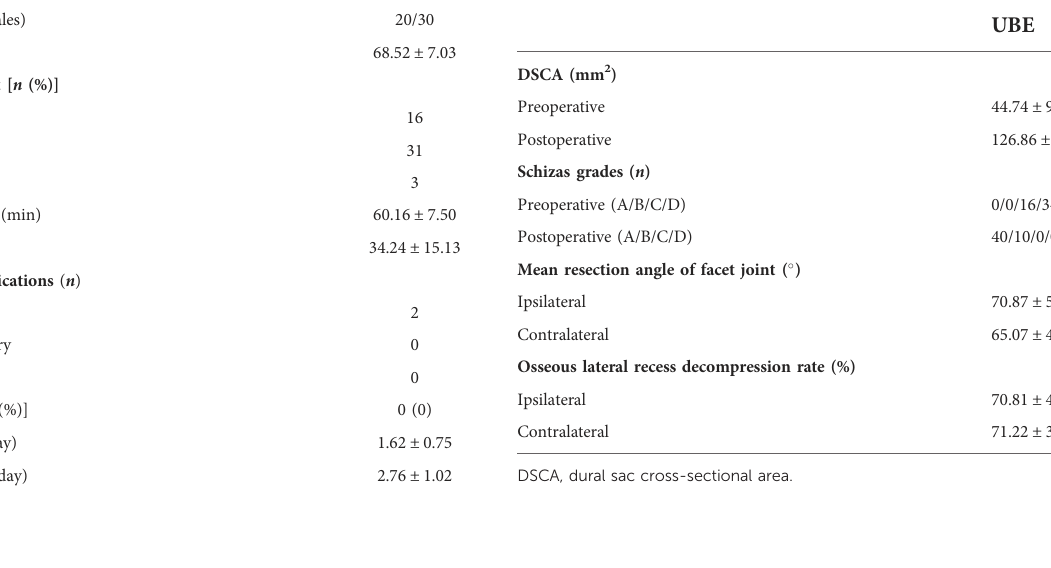
TABLE 1 General condition and surgical indicators of subjects.